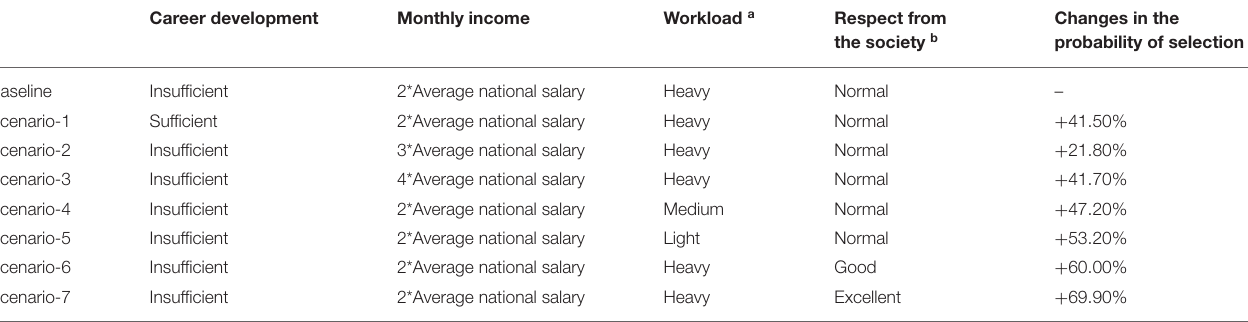
TABLE 4 | Job choice scenario